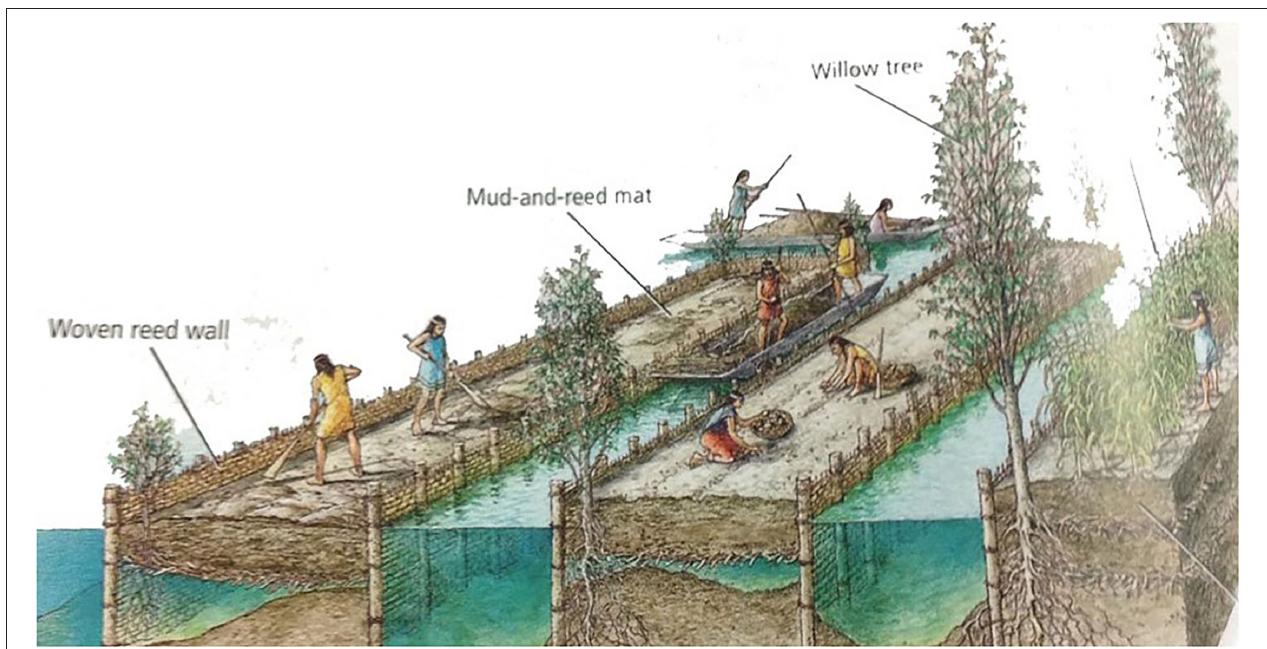
FIGURE 5 | An artist’s conceptual illustration of chinampas, a wetland agriculture-aquaculture system that was common from the valley of Mexico City to the western Amazon regions of South America. Development of the systems stretch back as far as 6,000 years B.P. From Aghajanian